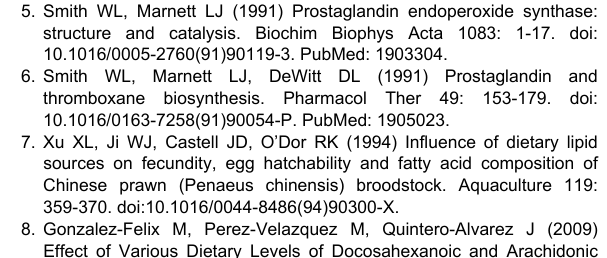
Figure S1. Schematic representation of domain types and positions on each putative P. monodon prostanoid